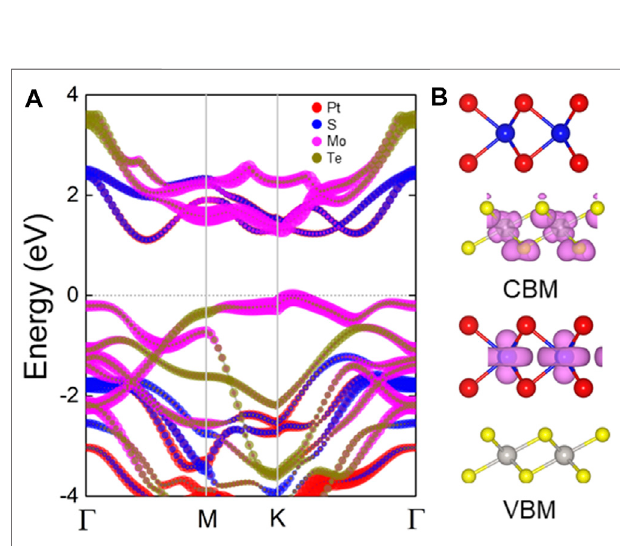
FIGURE 3 | (A) The HSE method obtained projected band structure and the (B) band-resolved charge densities of the PtS 2 / MoTe 2 vdW heterostructure; the Fermi level is expressed as 0 using gray dash line.